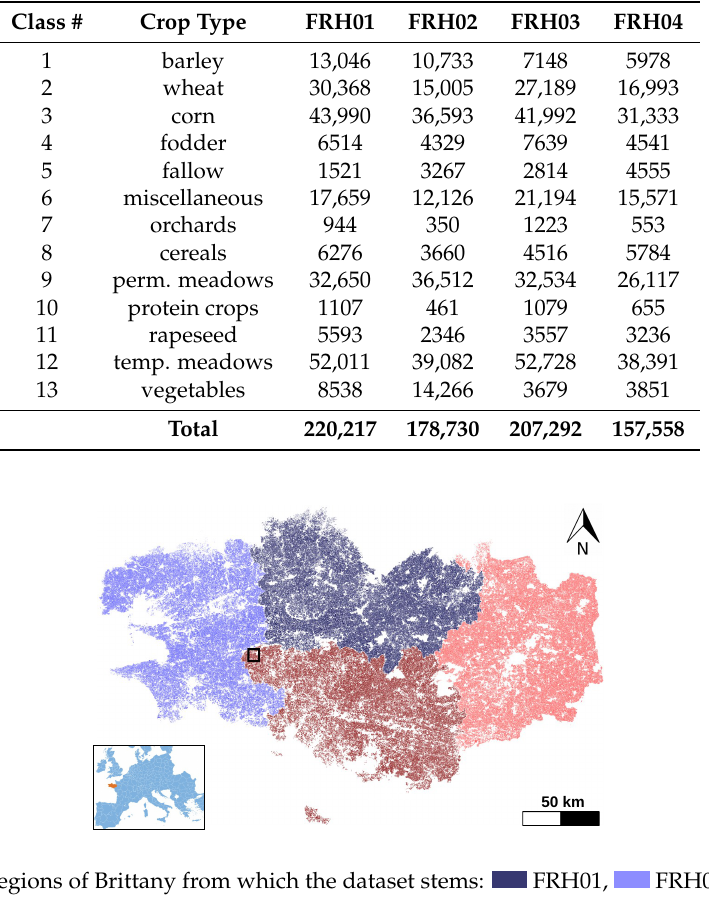
Table 1. The classes and their sizes for each region.